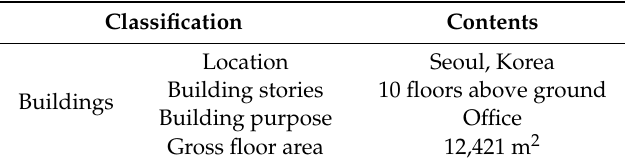
Table 5. Target building information.